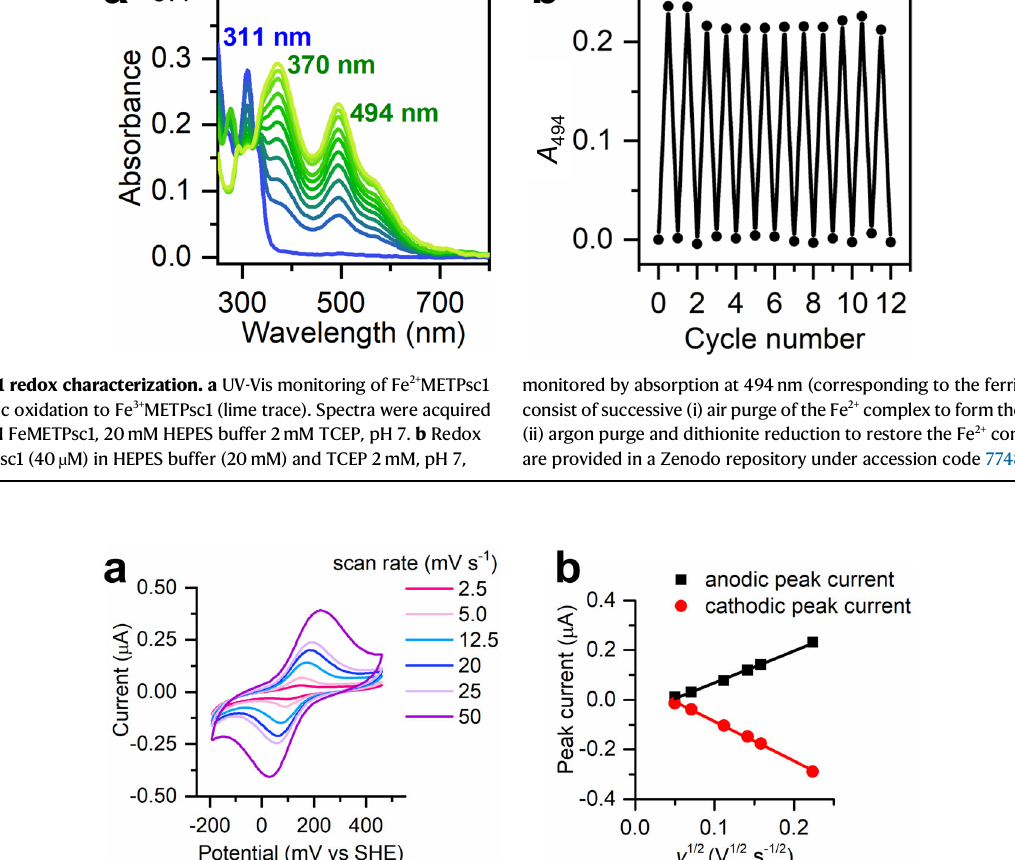
plotted as a function of the square root of the scan rate. Data points were fi tted to the Randles- Š ev č ík equation, allowing to determine the diffusion coef fi cient of FeMETPsc1 both in the reduced ( D red=0.92 10 − 6 cm 2 s − 1 ) and in the oxidized state ( D ox=1.4 10 − 6 cm 2 s − 1 ). Source data are provided in a Zenodo repository under accession code 7748883.